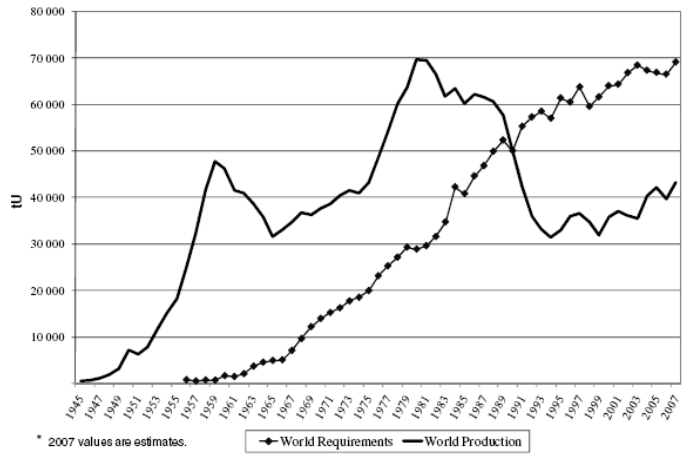
Figure 17. Annual uranium production and requirements. © 2008 OECD, reproduced from [96] with